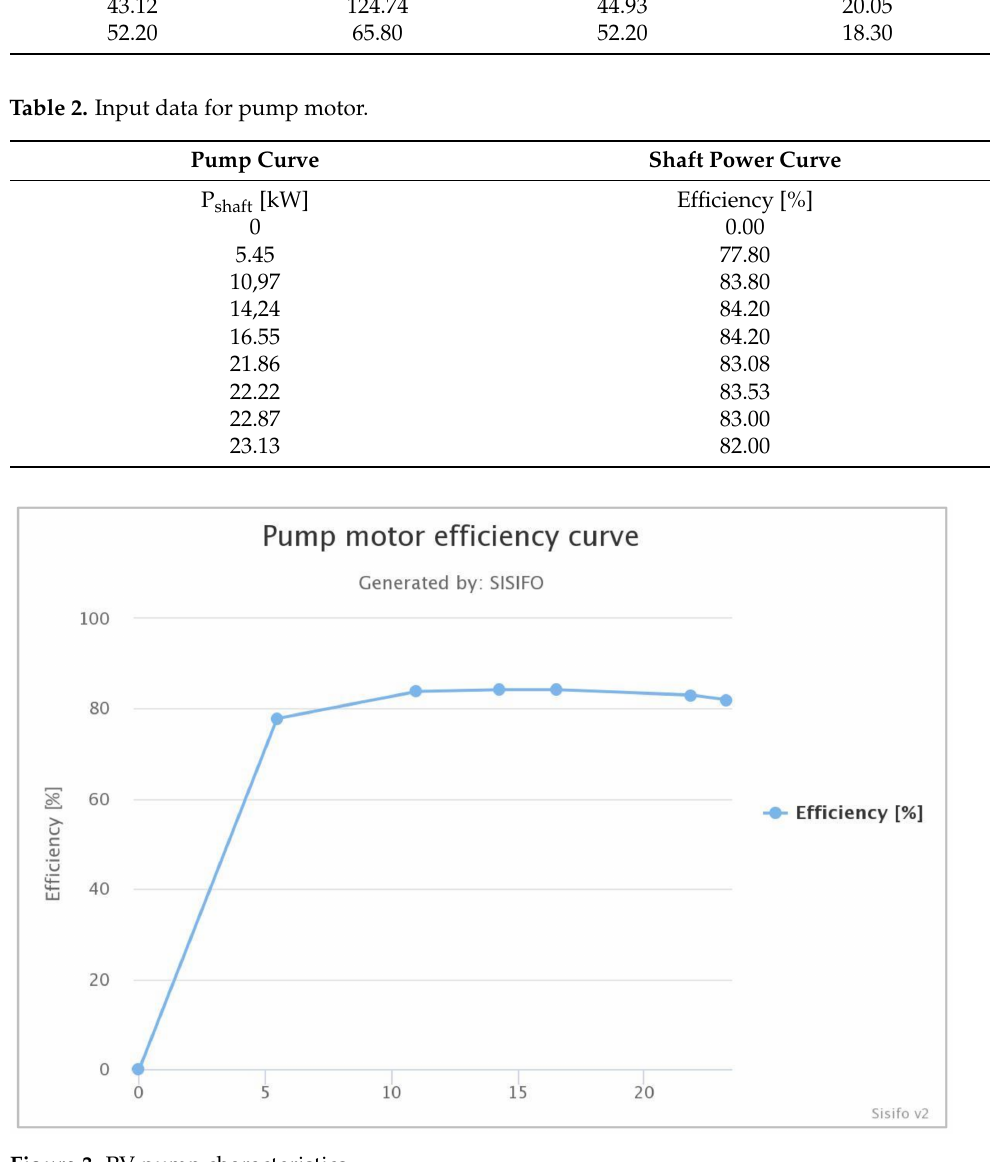
Figure 3. PV pump